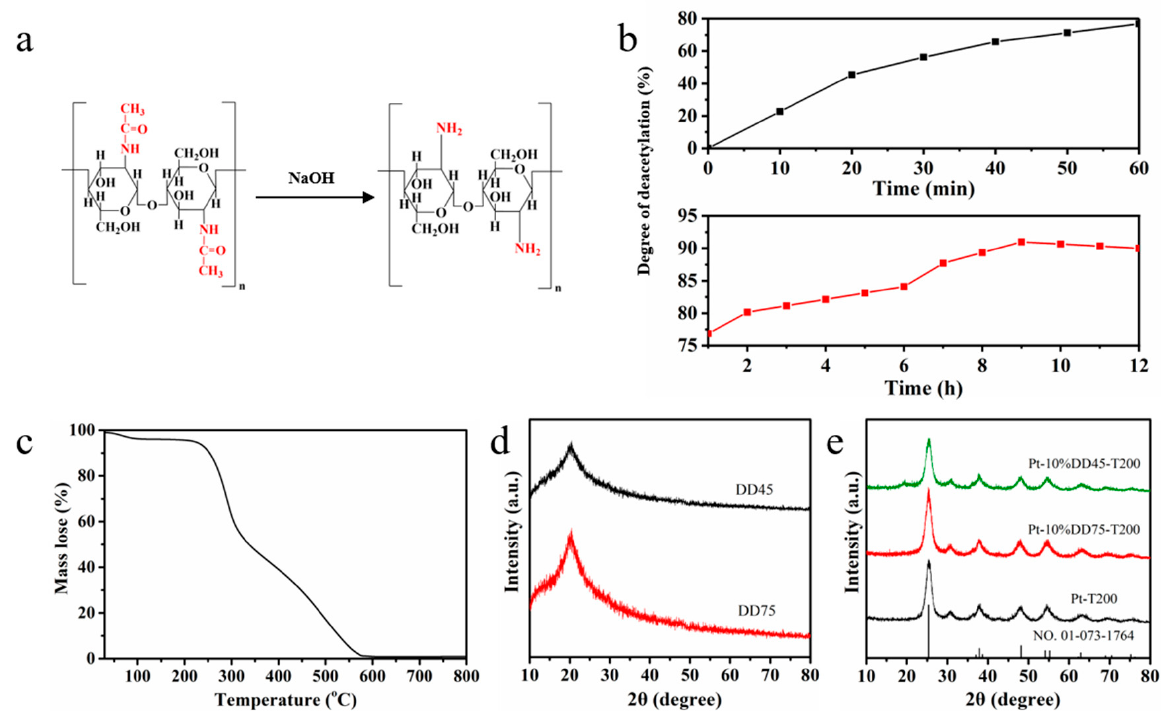
Figure 1. ( a ) Graph of degree of deacetylation of chitosan varying with the reaction time; ( b ) reaction of the deacetylation of chitin; ( c ) TGA curve of chitosan; ( d ) XRD patterns of DD45 and DD75, and ( e ) XRD patterns of Pt-T200, Pt-10%DD45-T200, and Pt-10%DD75-T200;